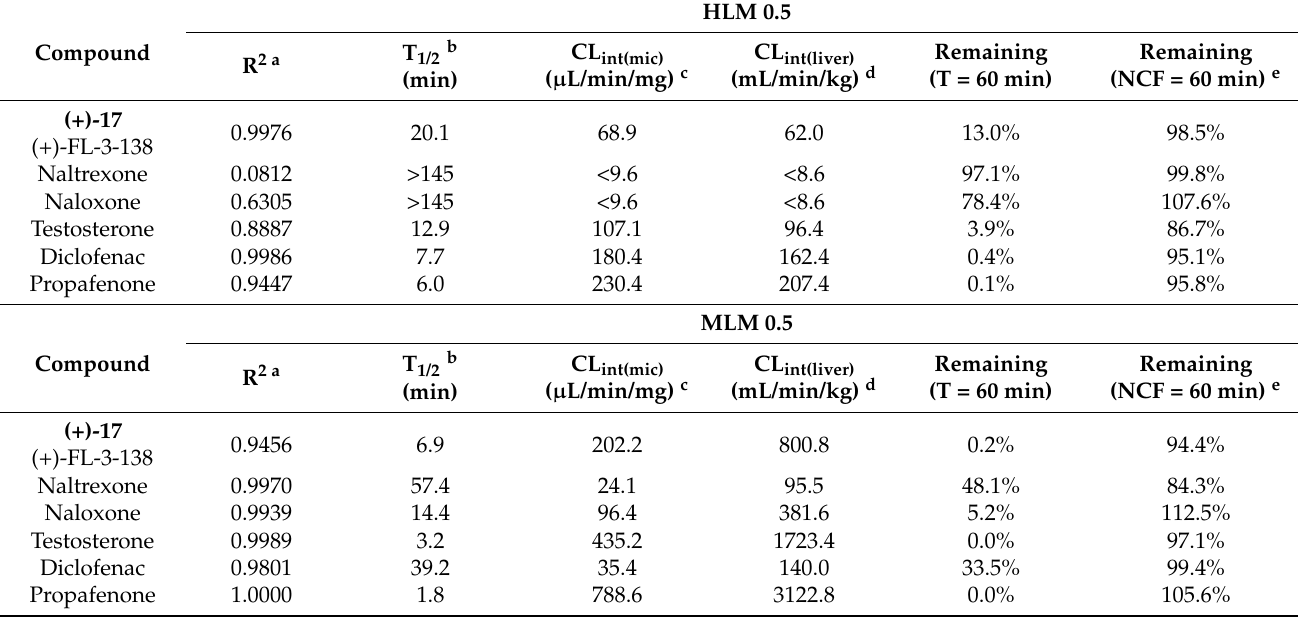
Table 4. Microsomal metabolic stability study of test compounds with human and mouse liver